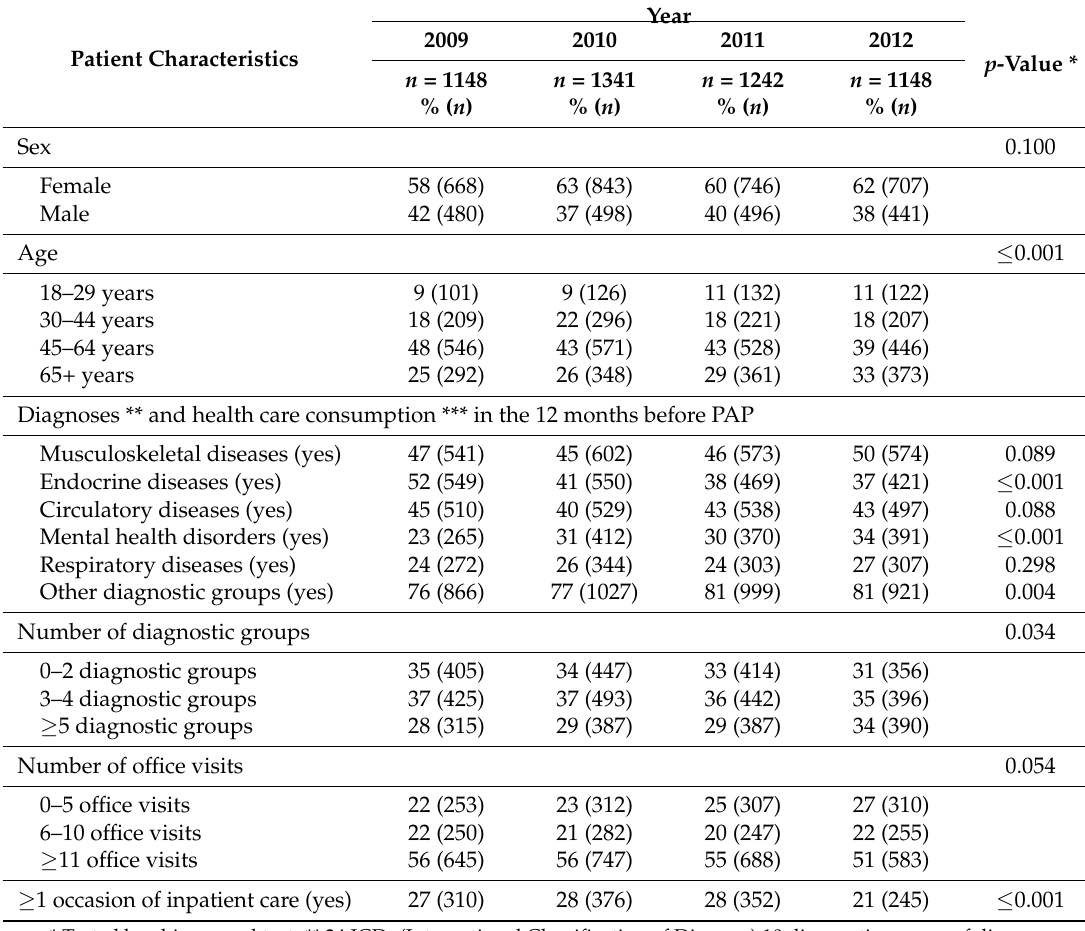
Table 1. Patients receiving PAP (Physical Activity on Prescription) in primary and secondary care and differences between years of